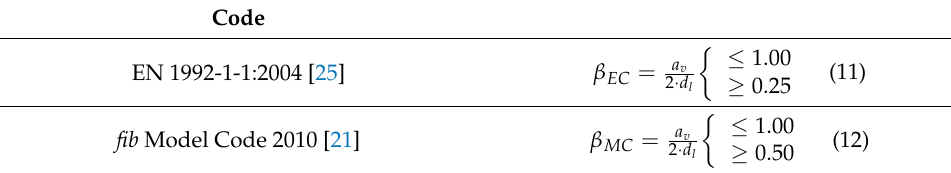
Table 1. Definition of the factor β according to different guidelines. Code